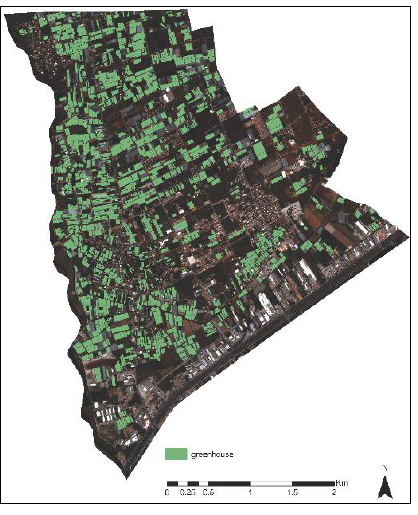
Figure 3. Thematic vector data.